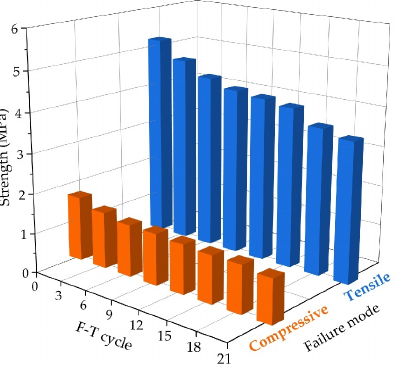
Figure 4. The compressive and tensile strength results under F-T conditions.